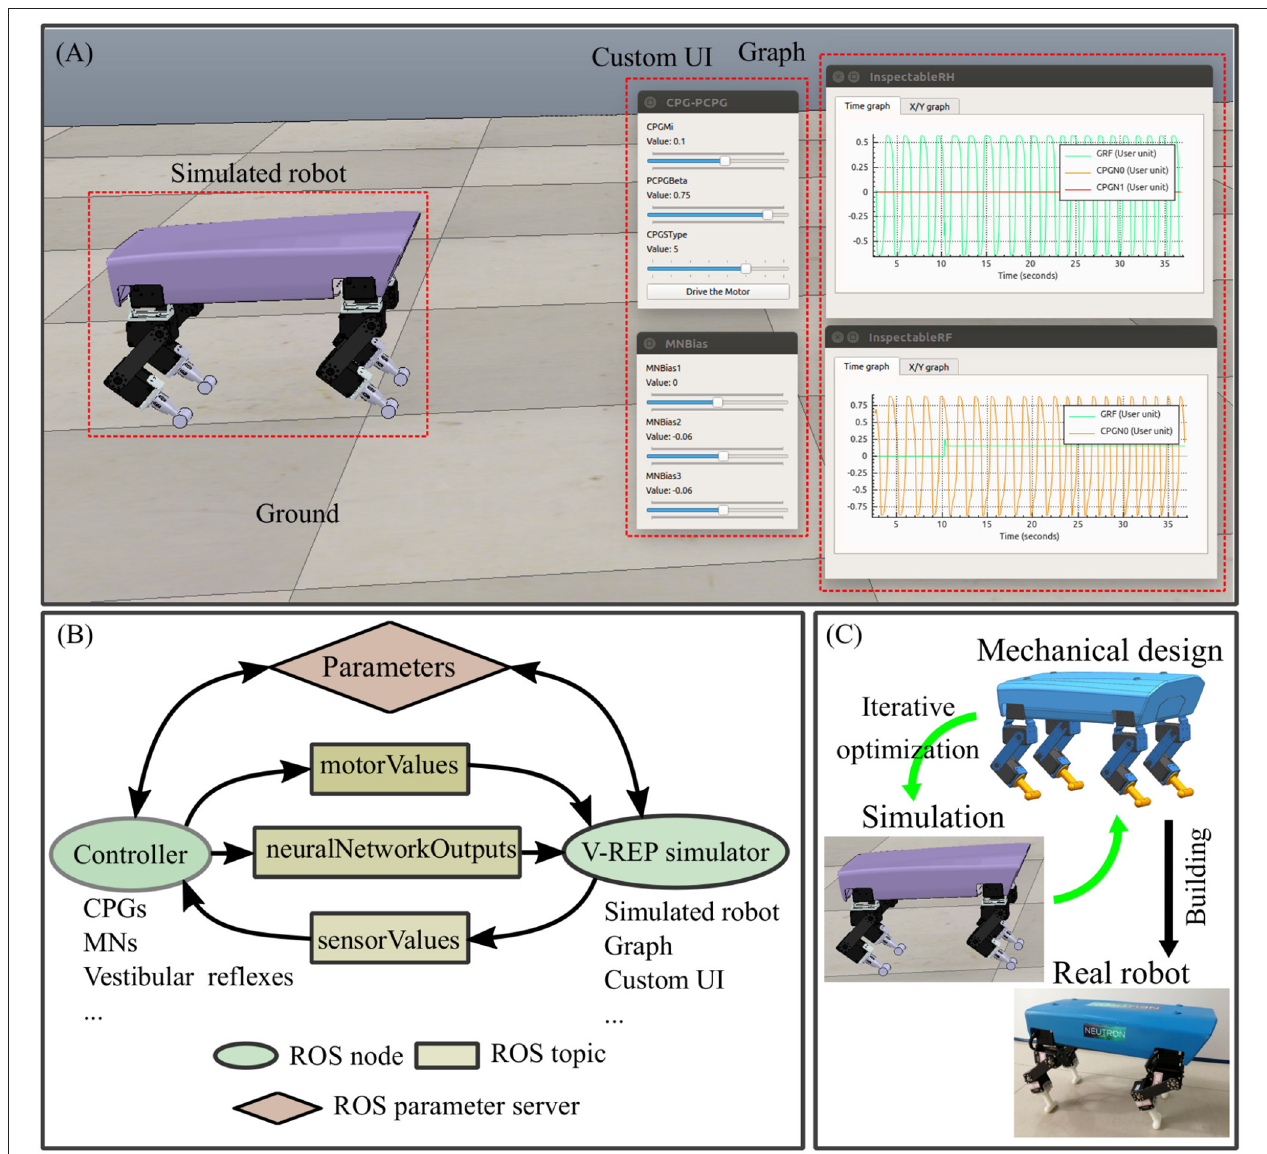
FIGURE 2 | Lilibot simulation and its developmental process. (A) The virtual robot experimentation platform (V-REP) (Rohmer et al., 2013) simulation scene of Lilibot. The mechanical model of Lilibot is loaded into the V-REP to create a simulated robot in a virtual environment. The V-REP provides the graph tools to monitor various signals (including motor commands, outputs of the sub-control modules, and sensory signals). Besides, the custom UI of the V-REP can be used to adjust the control parameters [such as in this study, CPG frequency and amplitude as well as sensory feedback strength of the decoupled CPGs control (see Tao et al., 2018) and the weight parameters of the vestibular reflex control ( Figure 7 )]. (B) The simulator is based on the V-REP and the robot operation system (ROS) (Quigley et al., 2009). The communication between the controller (ROS node1) and the simulator (ROS node2) is accomplished through three ROS topics and a parameter server. The topics include (1) a “motorValues” topic transmitting motor commands of joints from the controller to the simulated robot; (2) a “sensorValues” topic transmitting sensory signals of the simulated robot to the controller; (3) a “neuralNetworkOutputs” topic transmitting the outputs of the sub-control modules. The parameters of the controller are accessed through a ROS parameter server. The communication between the controller (ROS node1) and the real robot (ROS node3) is also performed in the same manner through the ROS topics and the parameter server. (C) The mechanical design is iteratively optimized using the V-REP